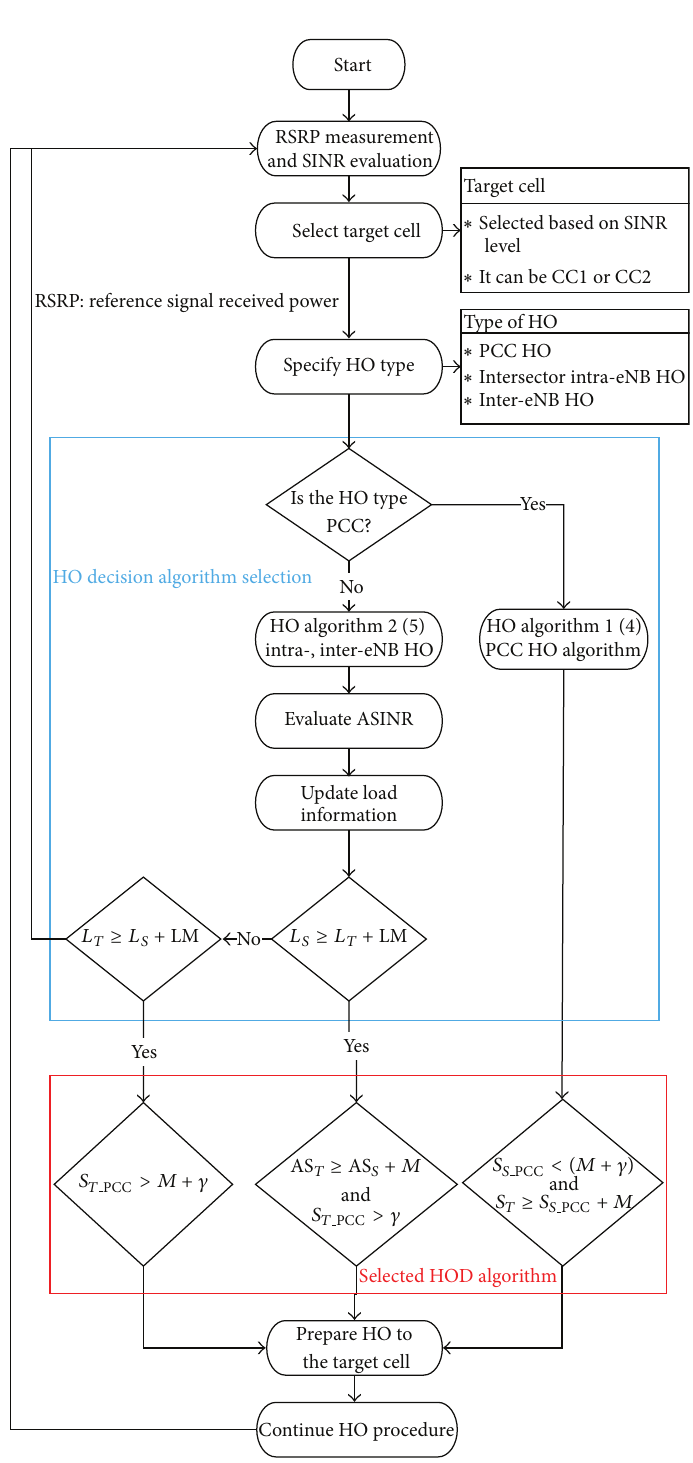
Figure 3: Flowchart of our proposed handover decision